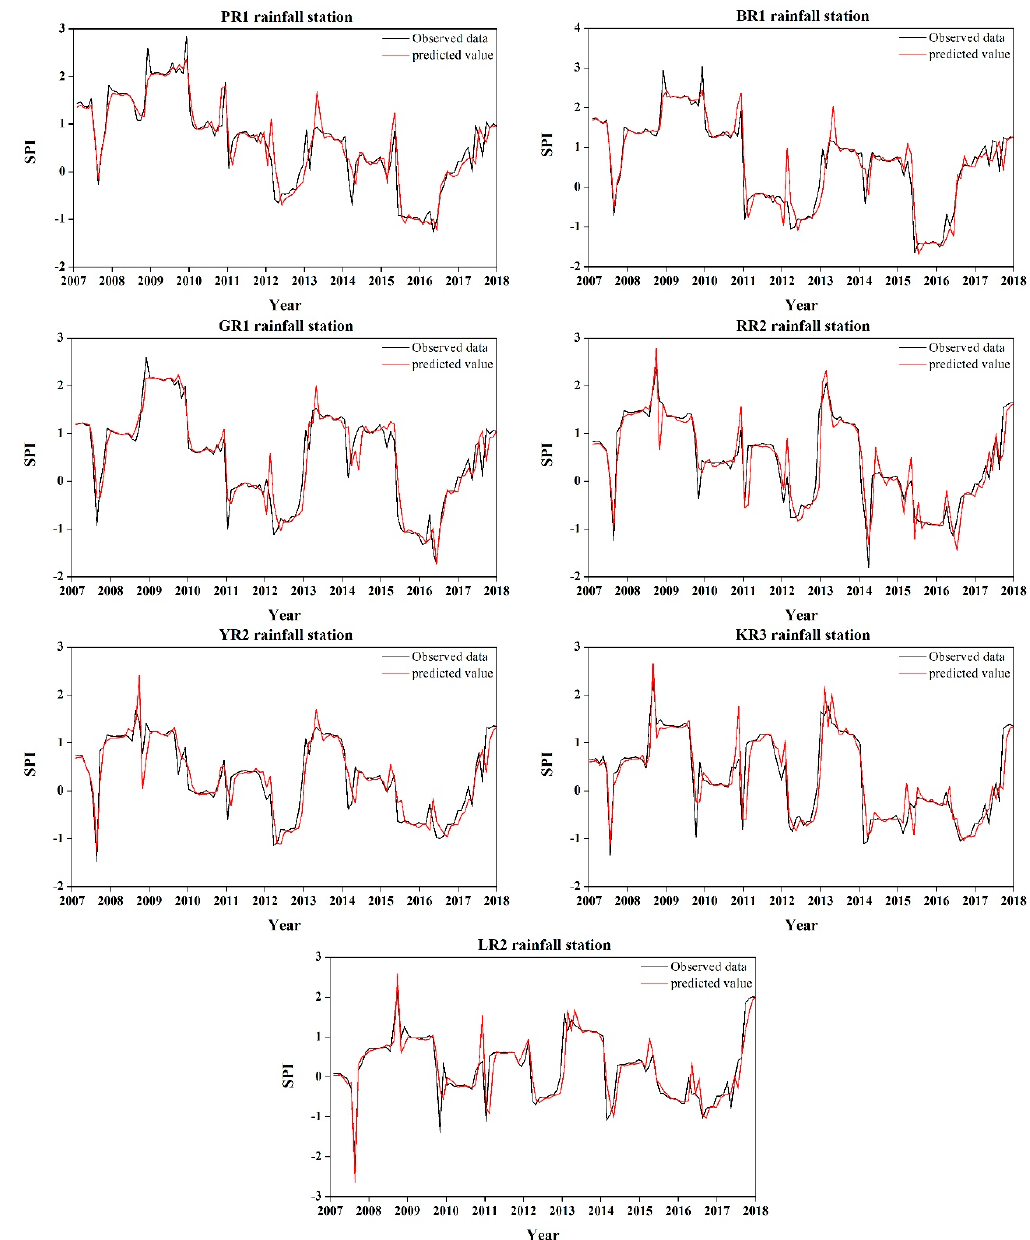
Figure 6. Comparison of observed data with predicted values using the best seasonal ARIMA (SARIMA) model at each basin. Table 5. Performance measures for the selected model for the observed data and predicted values.